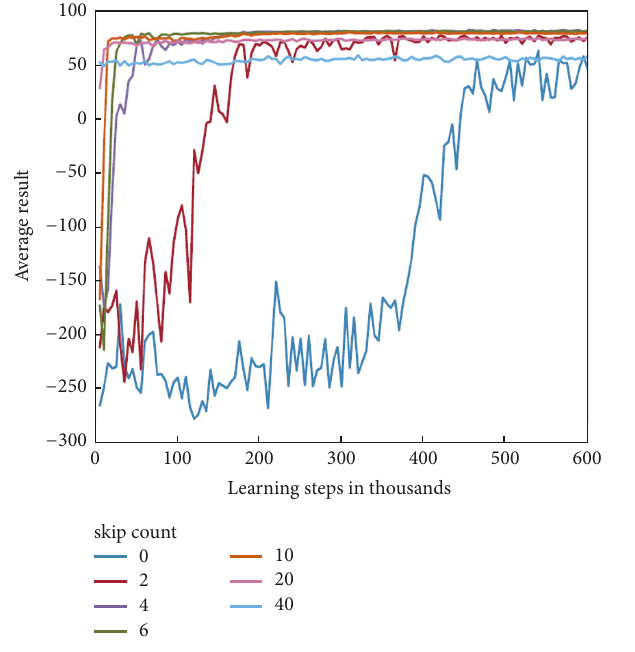
Figure 7: Target graph proposed in